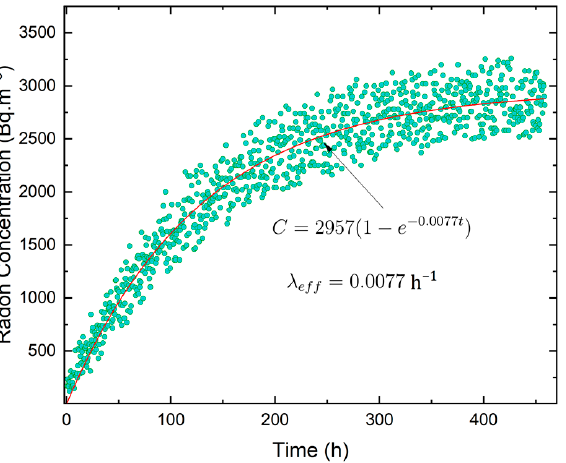
Figure 3. Experimental 222 Rn concentration growth and exponential fit of measured radon activity concentration inside the accumulation chamber.